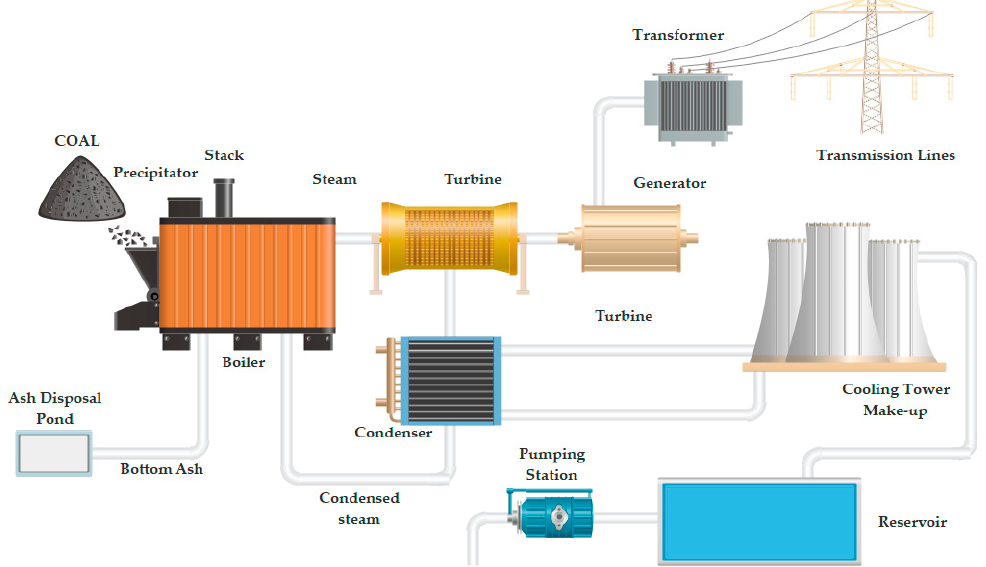
Figure 1. Essential equipment in a coal-fired